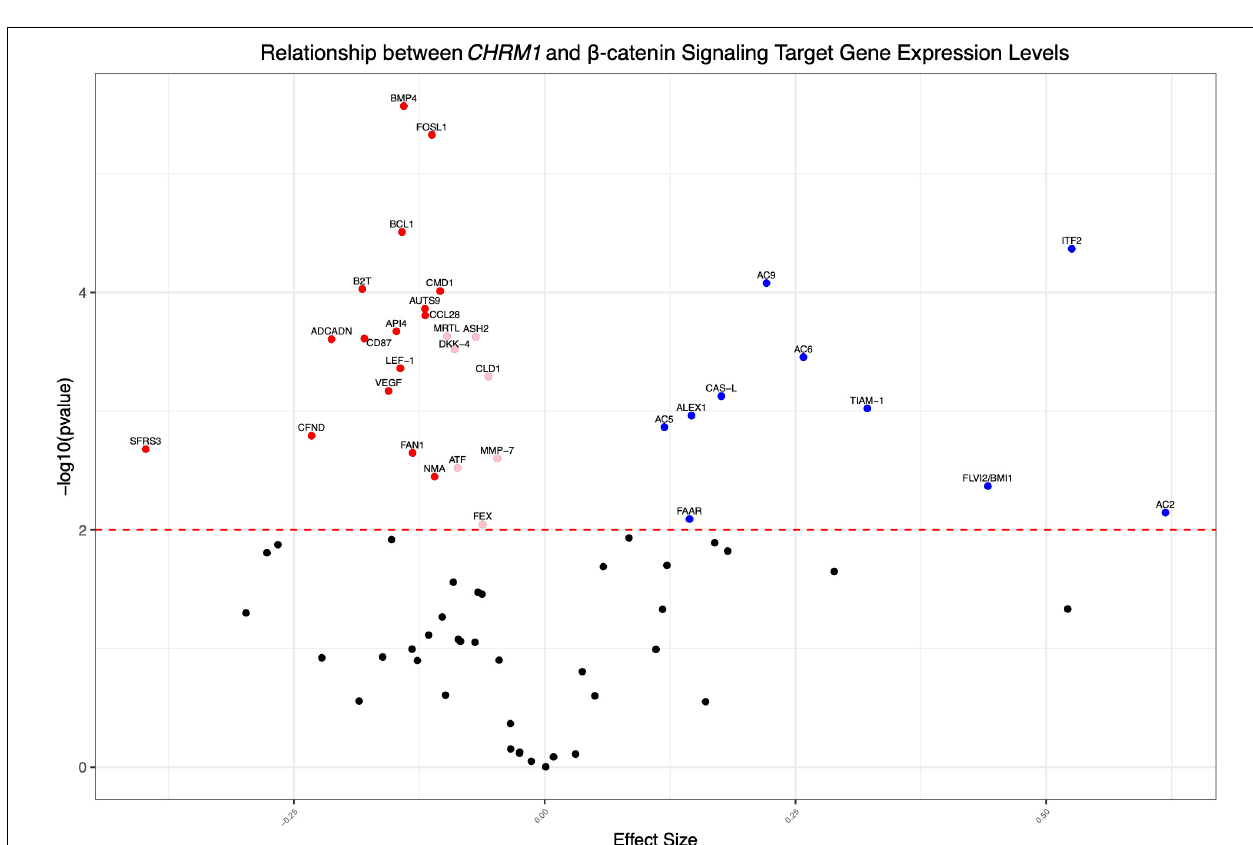
FIGURE 3 | CHRM1 expression is associated with multiple β -catenin signaling target genes. We modeled CHRM1 processed expression data as a function of the relevant β -catenin signaling and target genes using mixed (univariate) models, with participant ID as a random effect. β -catenin target genes previously associated with colon cancer and having a significant positive (blue symbols) or negative (red symbols) association with CHRM1 are shown.